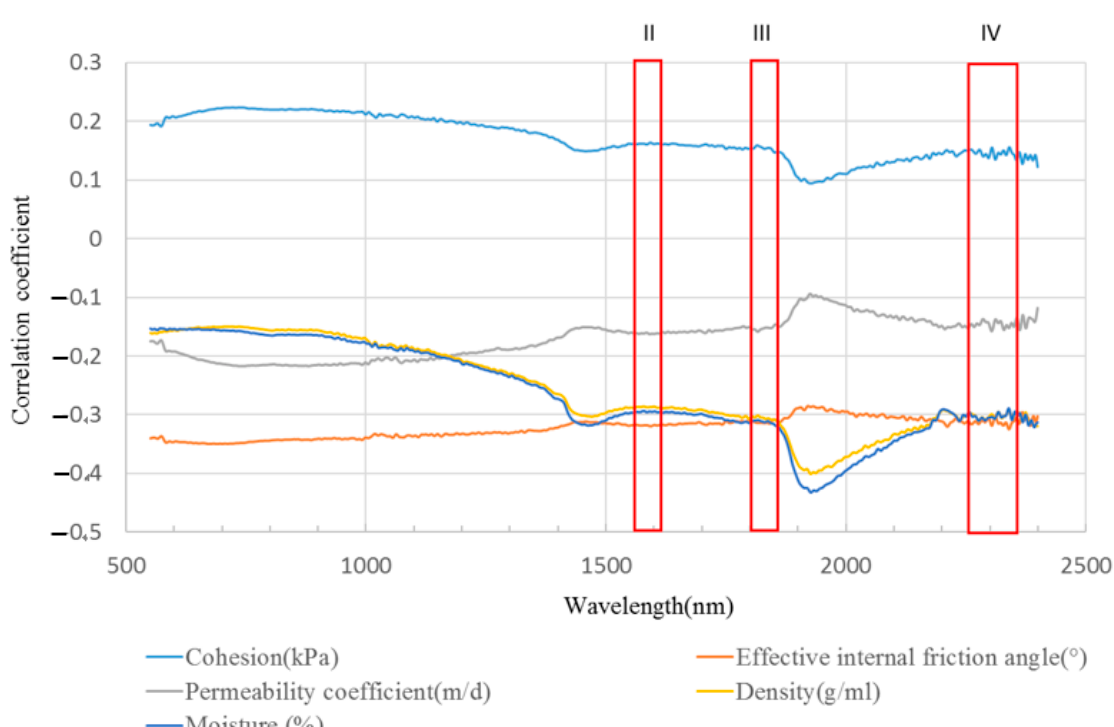
Figure 5. Correlation coefficients between cohesion, effective internal friction angle, permeability coefficient, density, moisture, and band reflectance (I–IV indicate the highly correlated segments between spectra and